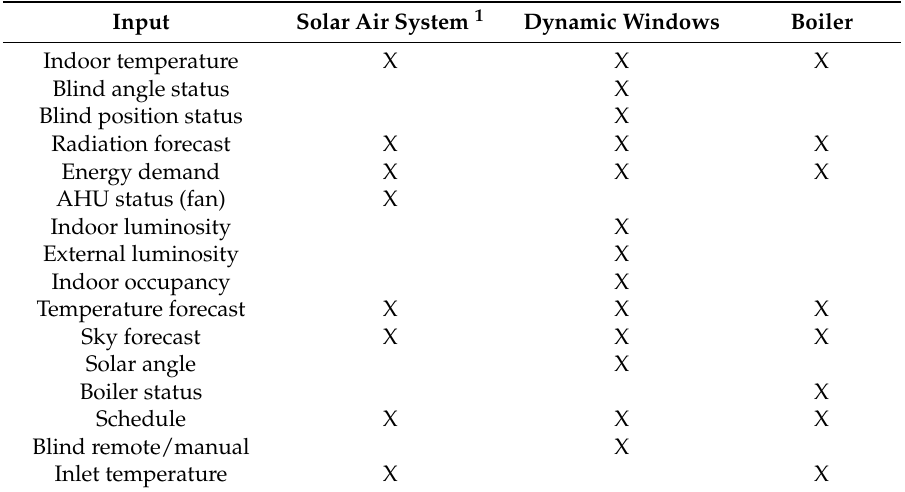
Table 2. Input parameter of the fuzzy logic.